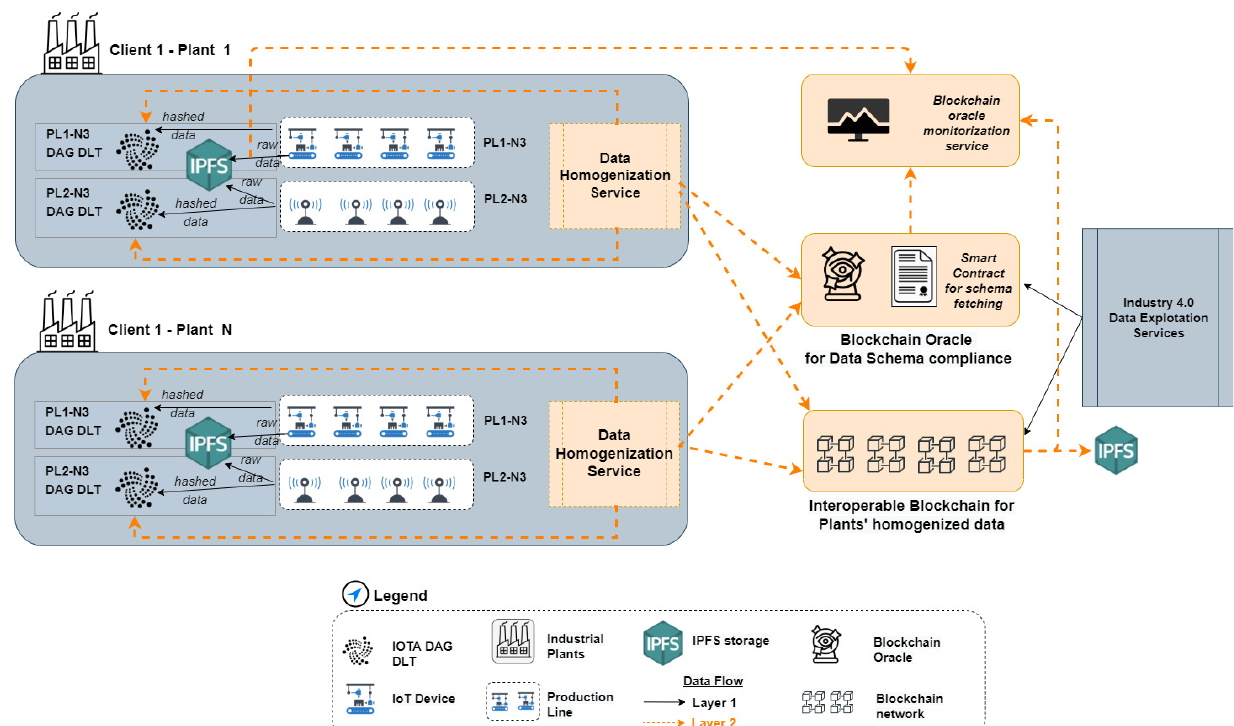
Figure 3. The proposed interoperable plant blockchain and data homogenization via decentralized Oracles